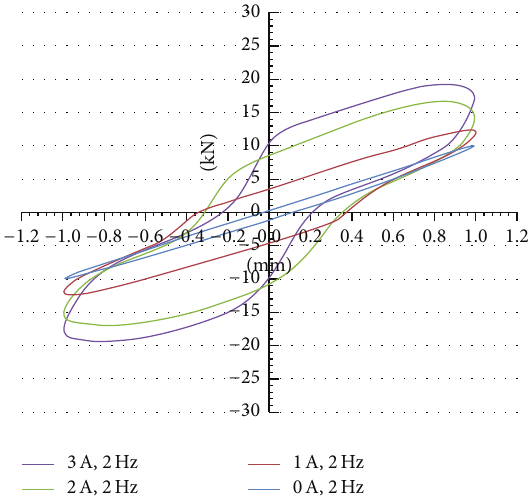
Figure 13: Block-up phenomenon of MR mount.